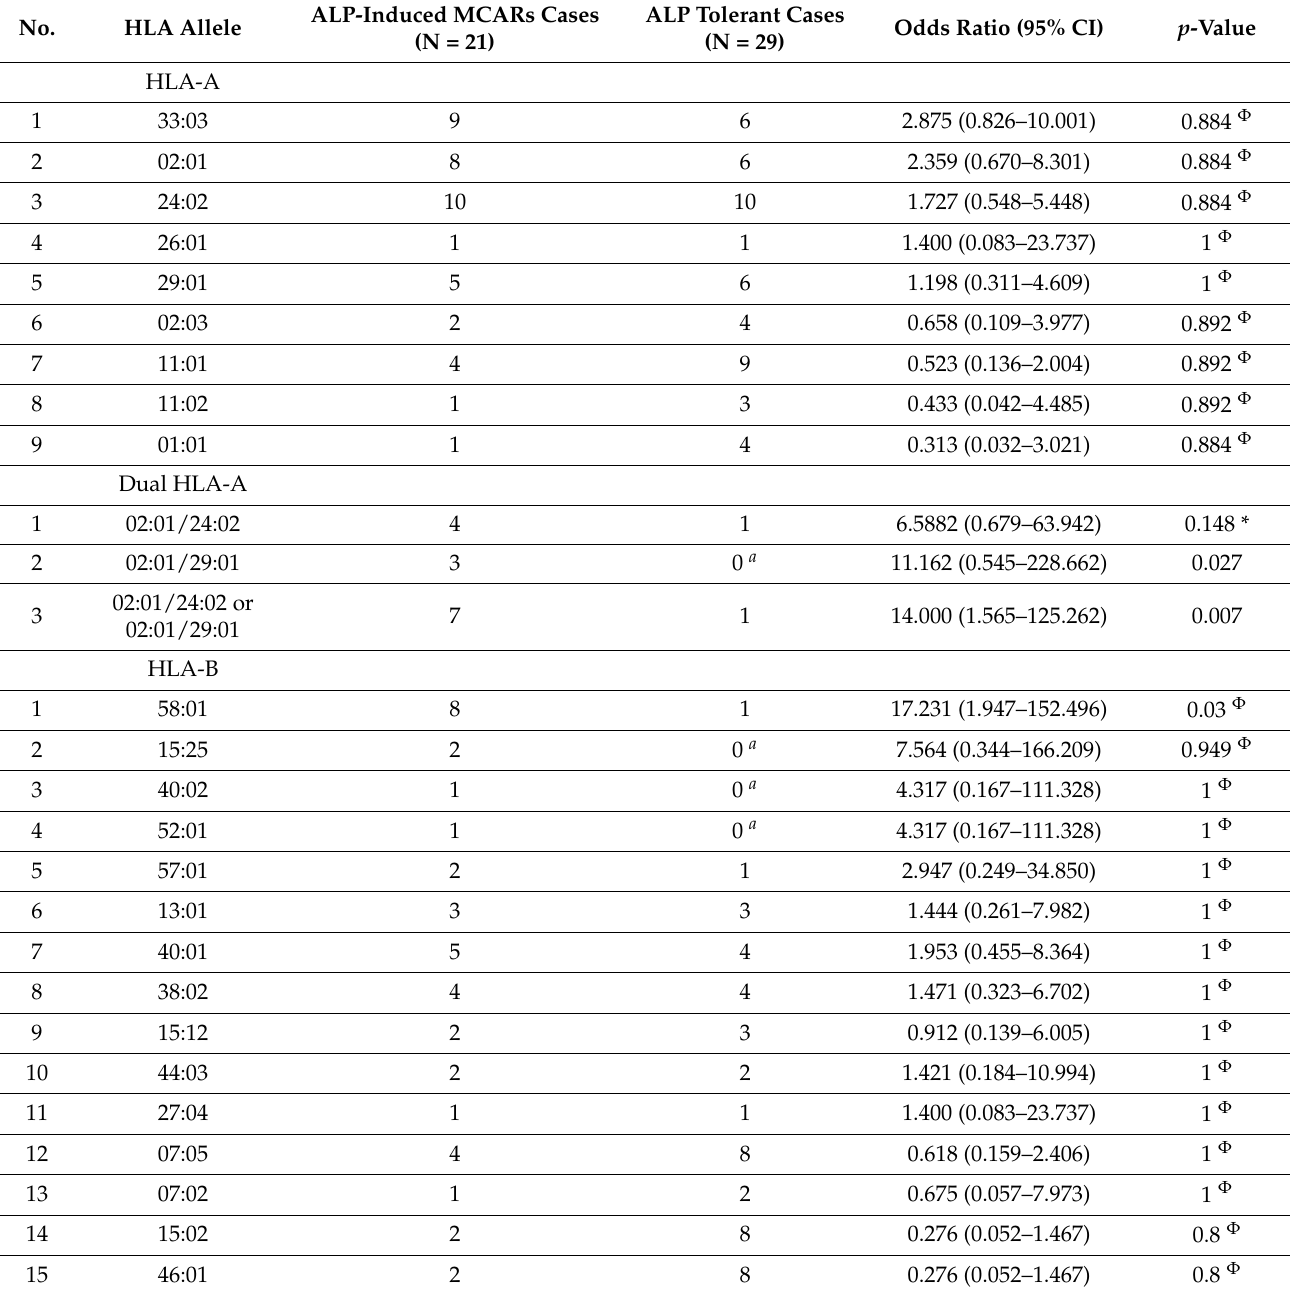
Table 4. Summary of cases with different single allele frequencies in patients with ALP-induced MCARs and ALP-tolerant patients.